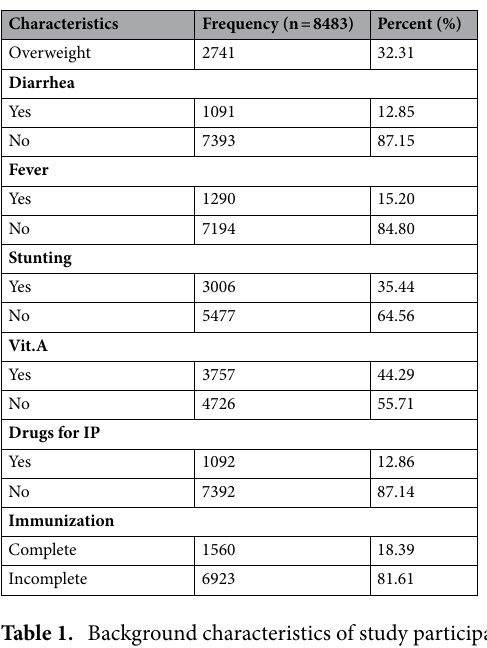
Table 1. Background characteristics of study participants.